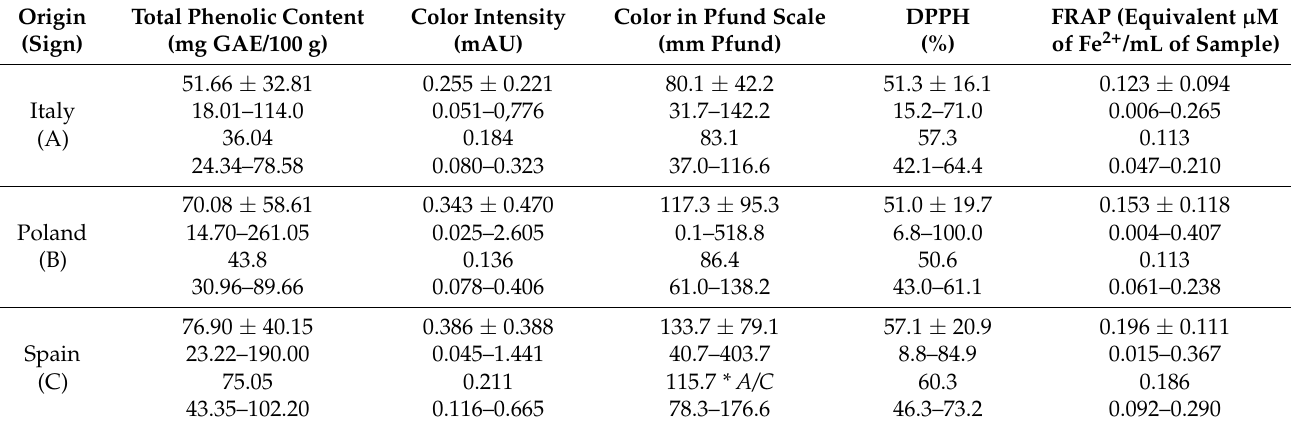
Table 5. The results of research on antioxidant properties—division into country of origin.